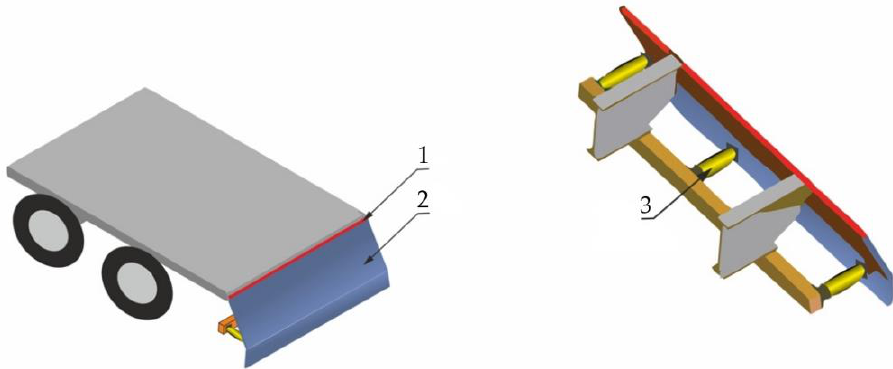
Figure 11. RUPD concept with a plate shielding the whole vehicle’s rear part under the cargo space. 1—Pivot; 2—Main Surface; 3—Energy Absorber (Crashbox).